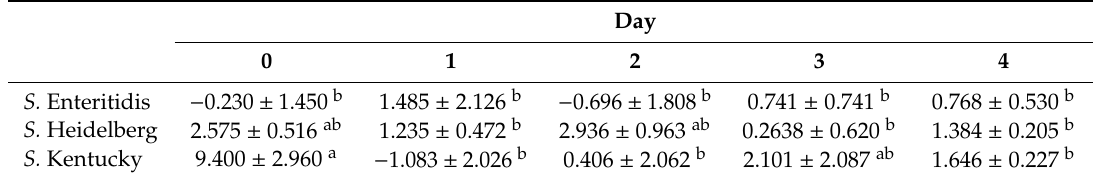
Table 5. Comparison of changes in expression of the ratio of the genes csgD and bcsA in the interaction between Salmonella serovars and a 4-day time period 1,2